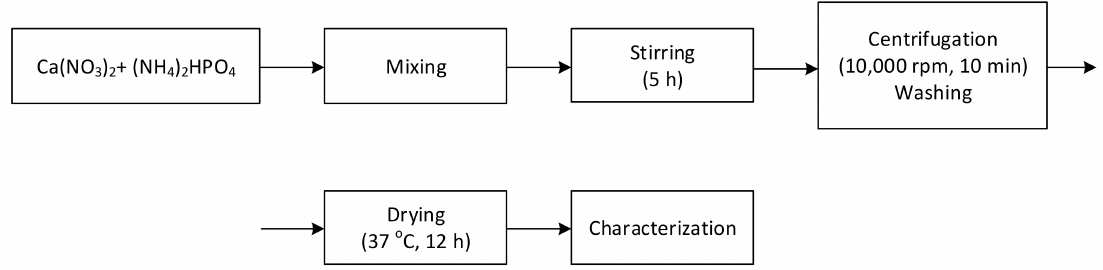
Figure 1. Synthesis of the hydroxyapatite-alendronate